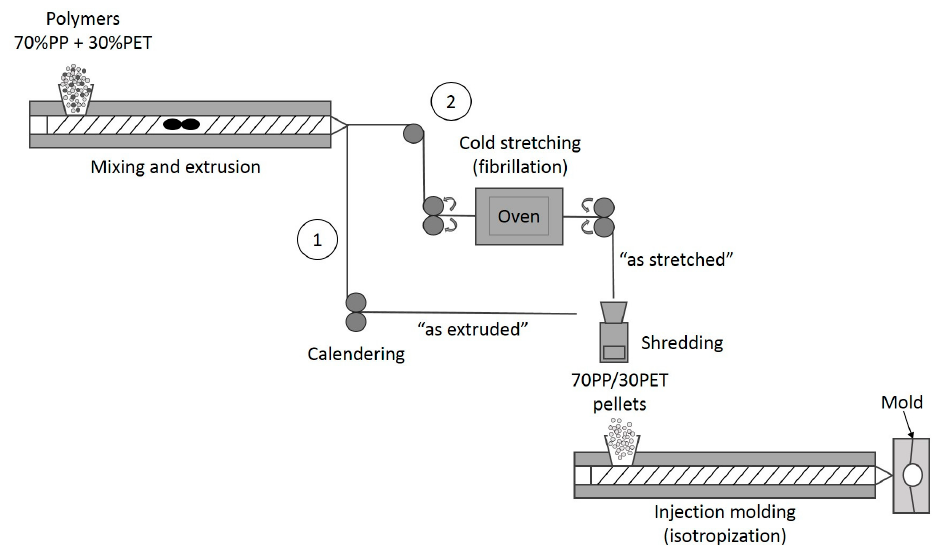
Figure 2. Processing scheme of: ( 1 ) IMBs (Injection molding blends) and ( 2 ) MFCs (Microfibrillar Composites).